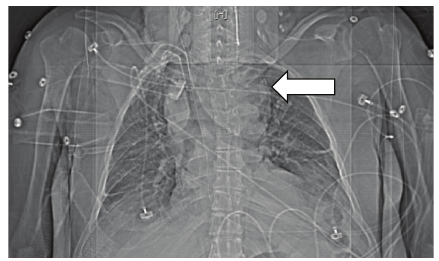
Figure 1: Massive retrosternal thyroid.